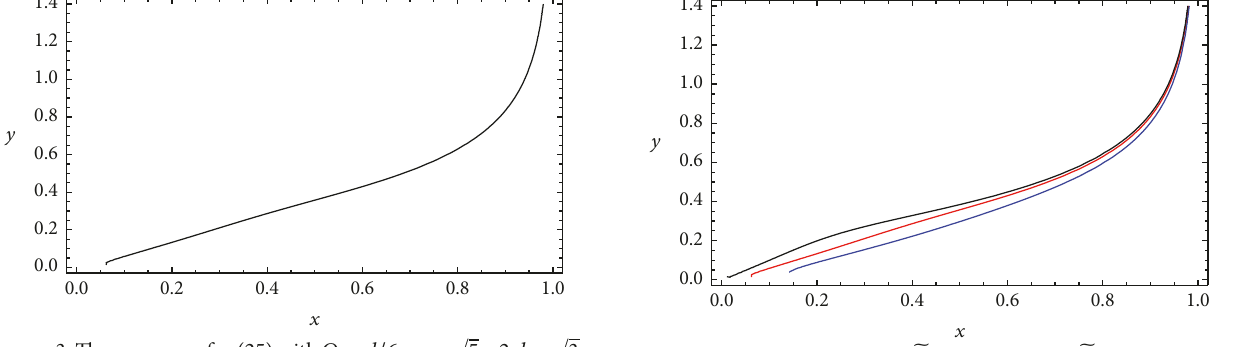
Figure 4: The 𝑦 - 𝑥 curves for Δ̃𝑄 = −0.05